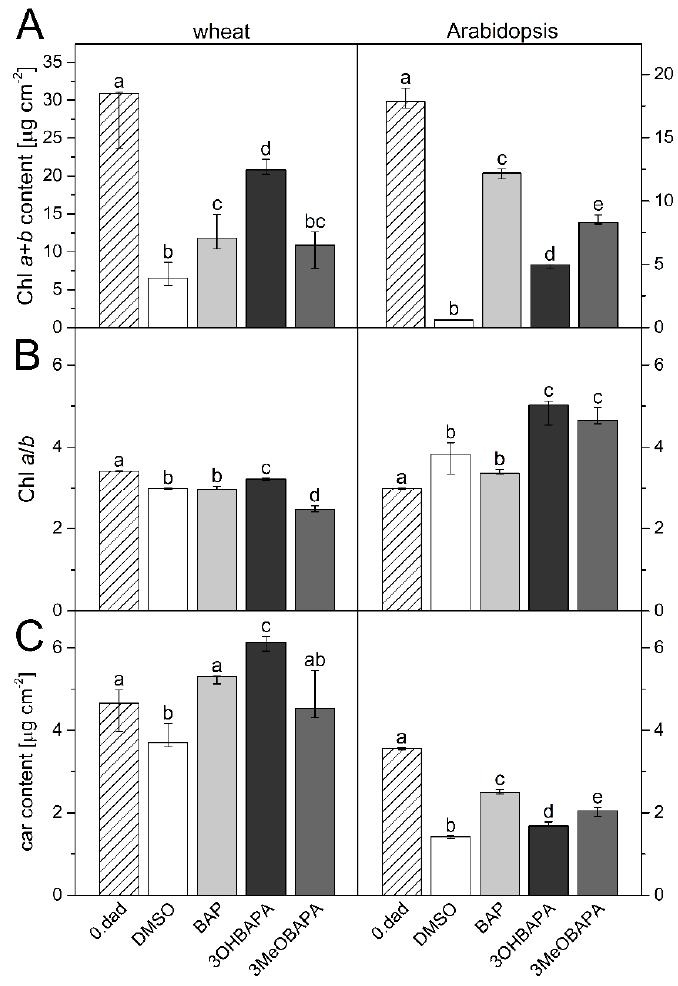
Figure 2. ( A ) Chlorophyll (Chl) a + b content; ( B ) Chl a / b ratio and ( C ) carotenoid (car) content in control (0. dad) and detached leaves of wheat and Arabidopsis after 6 days of dark incubation in 0.1% DMSO or 10-µmol·L − 1 solutions of 6-benzylaminopurine (BAP), 3OHBAPA and 3MeOBAPA. Medians and quartiles are shown ( n = 5). Different letters indicate a statistically significant difference between treatments within a plant species ( p < 0.05; Student’s unpaired t -test).